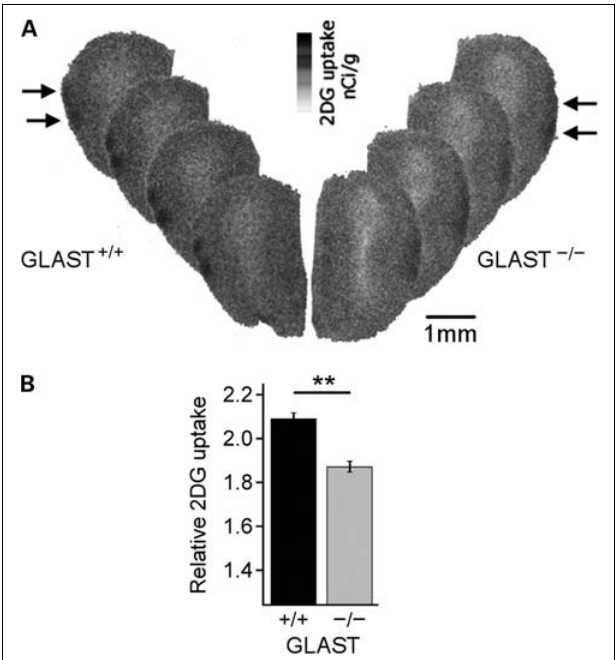
FIGURE 2 | Odor-induced 2DG uptake in olfactory glomeruli. (A) [ 14 C]-2-deoxyglucose local uptake in the glomerular region of the OB under odor stimulation (benzaldehyde 2%) is weaker in GLAST − / − mice compared to control animals. In the representative digitized autoradiograms, gray scale illustrates the level of 2DG uptake for one animal of each genotype (left: GLAST + / + ; right: GLAST − / − ) and for four consecutive slices of 20 μ m thickness. Activated glomerular regions are the black areas at the periphery of the structure (arrows). (B) Relative 2DG uptake averaged for all the animals [GLAST + / + ( n = 11); GLAST − /